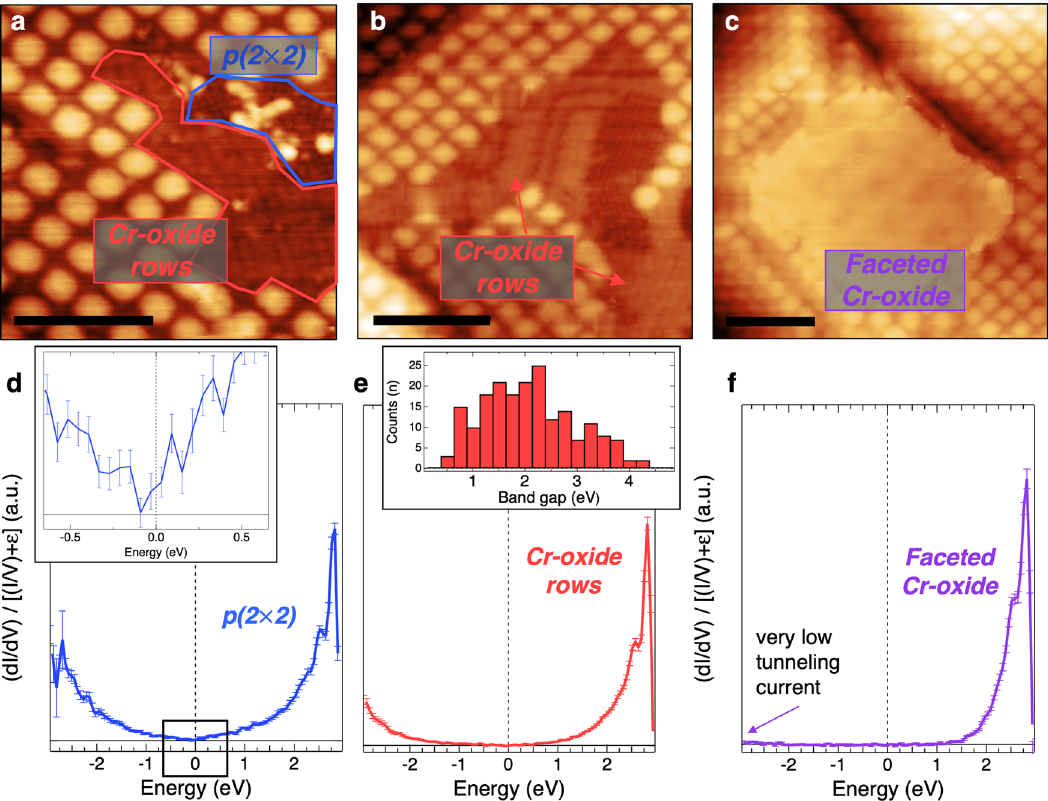
Fig. 5 Cr-oxide features and growth. Topography images of the Cr-oxide rows ( a ) and ( b ) and faceted Cr-oxide feature ( c ), tentatively assigned to the Cr-oxide pathway (detailed discussion of assignment in the text). The STS curves of each of these features are shown in ( d ) – ( f ). The STS for the p(2 × 2) and oxide rows in ( d ) and ( e ) were both recorded from their respective regions marked in the image ( a ). A close-up of the normalized spectra near the Fermi energy is included in ( d ) and a band gap distribution of the Cr-oxide rows is shown in ( e ). The STS for the faceted Cr-oxide, ( f ), was measured in the region marked in topography image ( c ). Image ( a ) was measured at V bias = − 3.0 V, I t = 0.1 nA, while images ( b ) and ( c ) were measured at V bias = − 3.0 V, I t = 0.05 nA. All scale bars are 10 nm. All error bars were calculated using standard